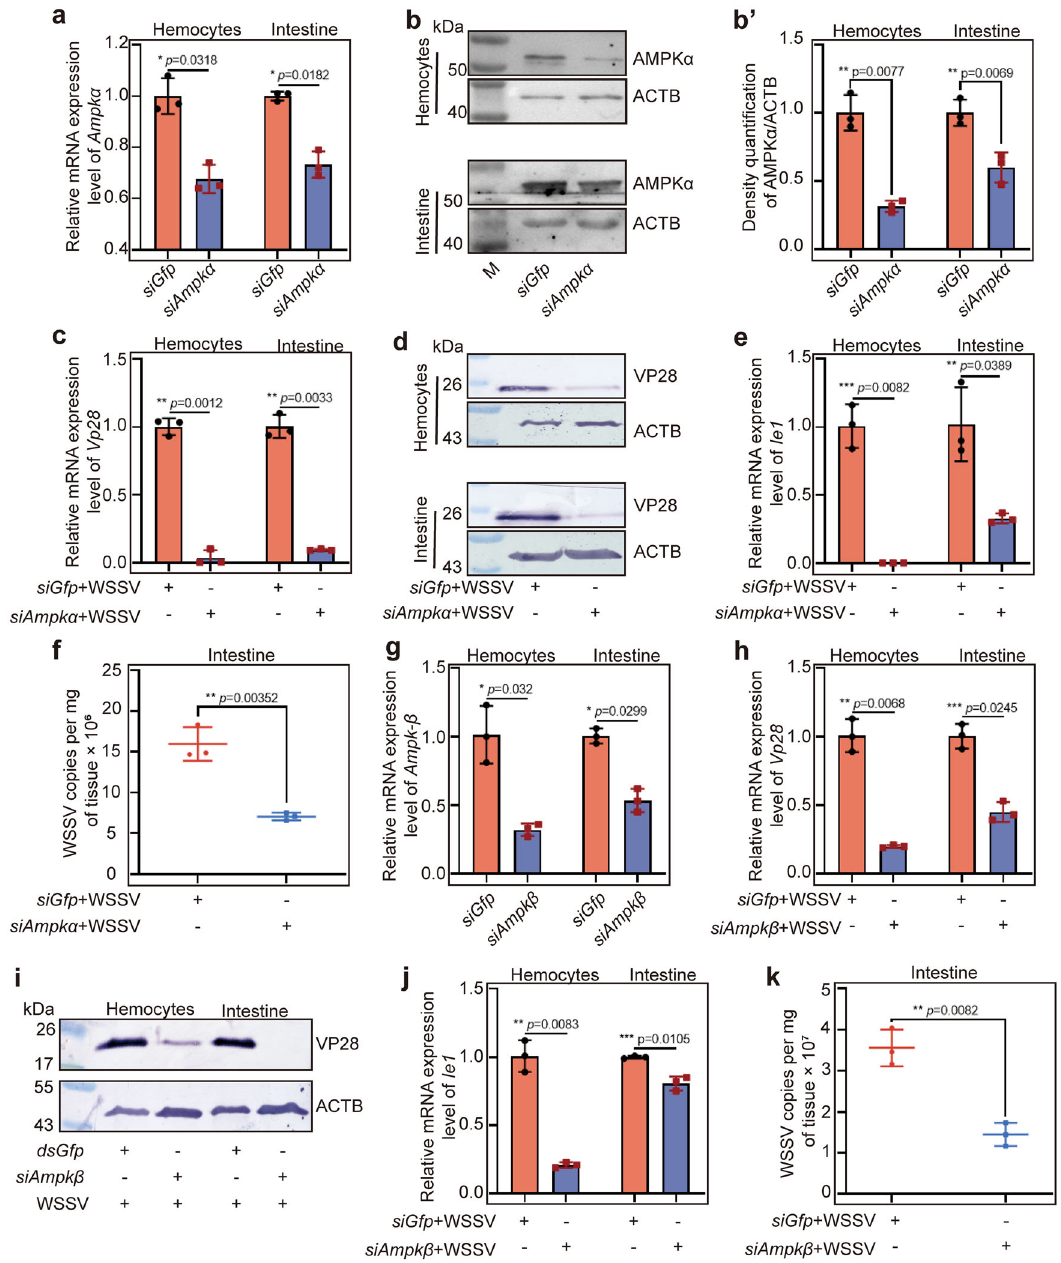
Fig. 2 WSSV replication is inhibited in Ampk -RNAi shrimp. a , b Ef fi ciency of Ampk α RNAi in hemocytes and intestines of shrimp 36 h post injection of siRNA, analyzed using qPCR ( a ) and western blotting ( b ). b ′ is the statistical analysis of panel b based on three replicates. c , d Expression levels of Vp28 mRNA ( c ) and protein ( d ) in hemocytes and intestine of the siGfp and siAmpk α injection groups challenged by WSSV. e Relative expression levels of Ie1 in hemocytes and intestine of Ampk α -RNAi shrimp. f copies of WSSV in the intestine of siGfp and siAmpk α groups after WSSV challenge. g RNA interference ef fi ciency of Ampk β in hemocytes and intestine of shrimp 36 h post injection, analyzed using qPCR. h , i Expression levels of VP28 at mRNA ( h ) and protein ( i ) levels in hemocytes and intestine of Ampk β -RNAi shrimp challenged by WSSV. j , k The relative expression levels of IE1 ( j ) in hemocytes and intestine and the number of copies of WSSV ( k ) in intestine of the shrimp infected by WSSV, analyzed using qPCR. Signi fi cant differences were analyzed